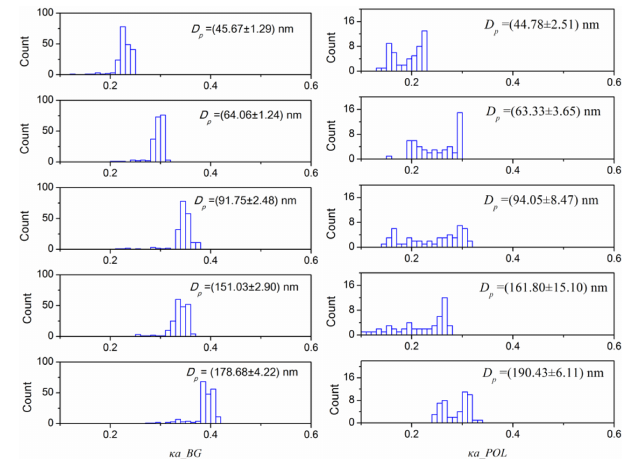
Figure 3. Probability distribution functions of D a under back- ground (_BG, left panels) and polluted (_POL, right panels) condi- tions at five SS levels (0.08–0.80%) during the size-resolved CCN measurement period.